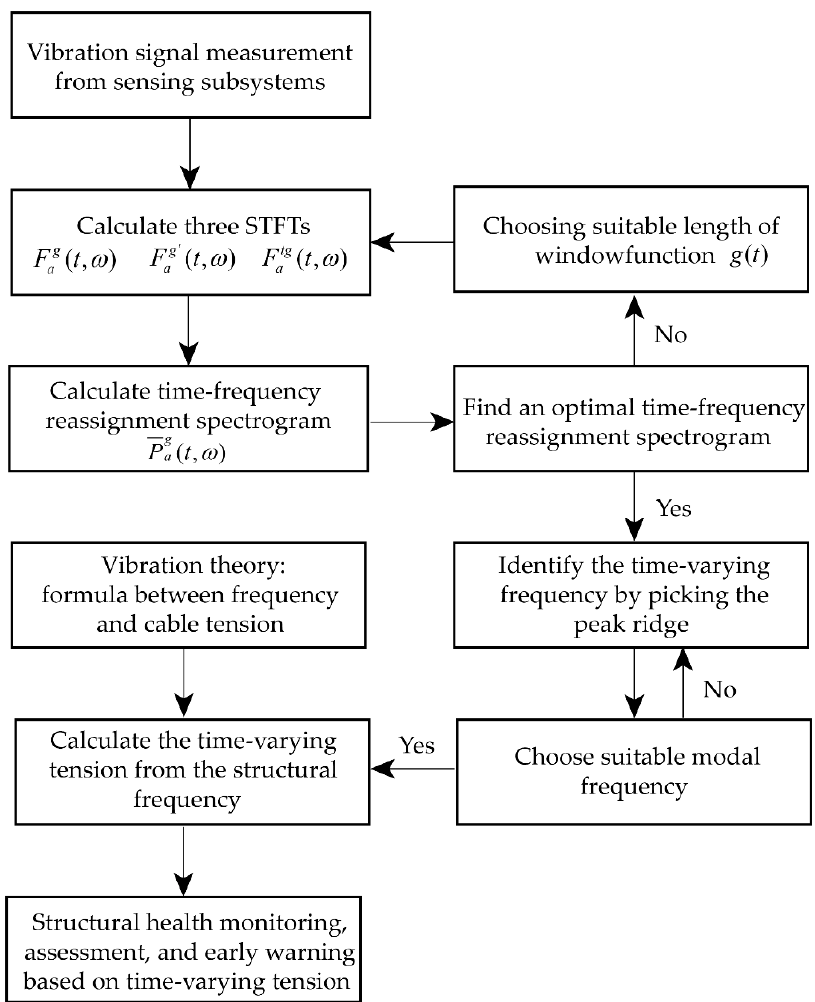
Figure 1. Algorithm flow of identification of time-varying cable tension based on TFR.